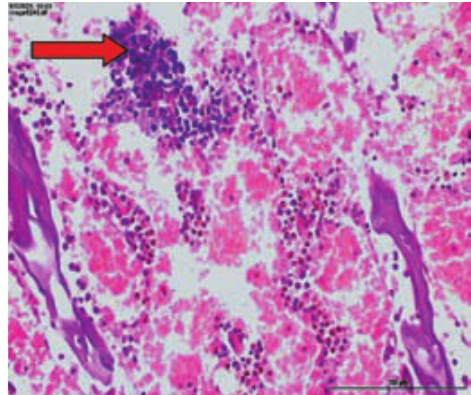
Fig. 4. Hypocellular bone marrow with areas of